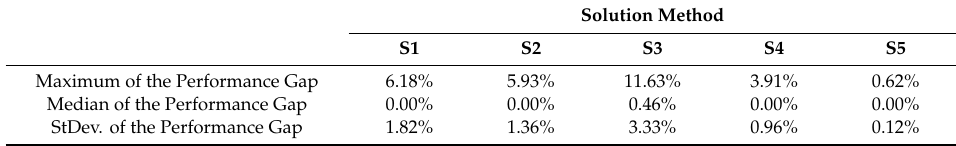
Table 5. The maximum, median, and standard deviation of the performance gap under (M, N) = (2, 6).